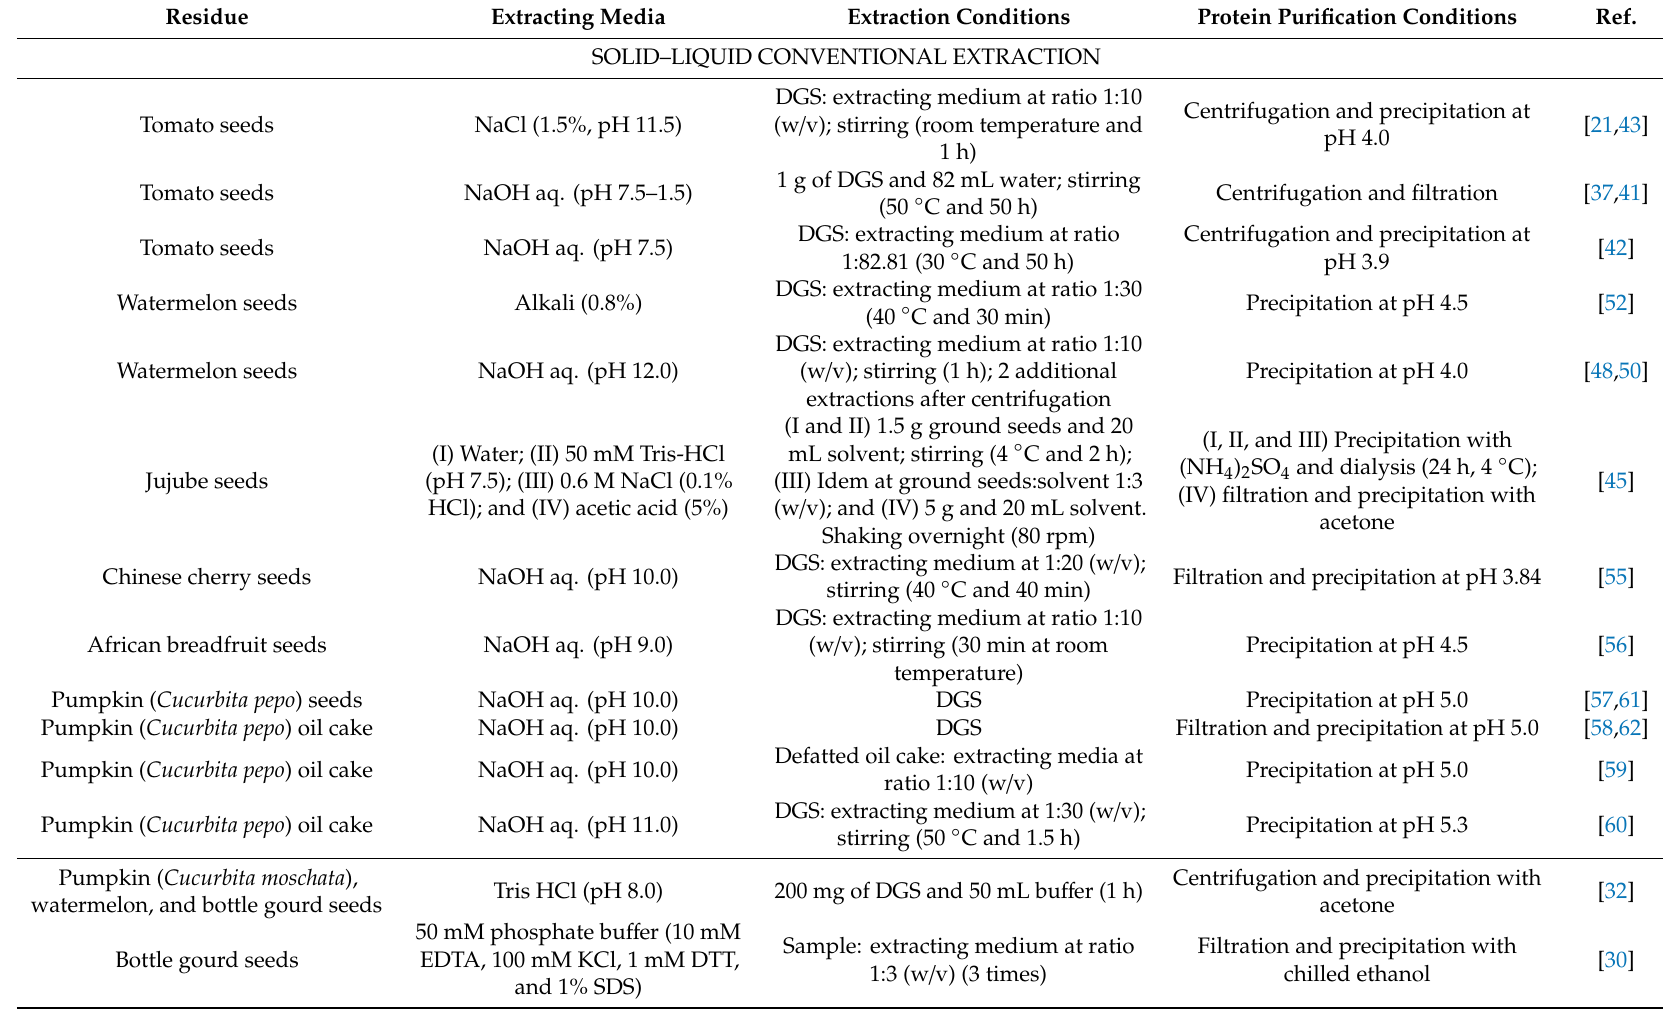
Table 1. Methods employed in the extraction and purification of proteins from fruit